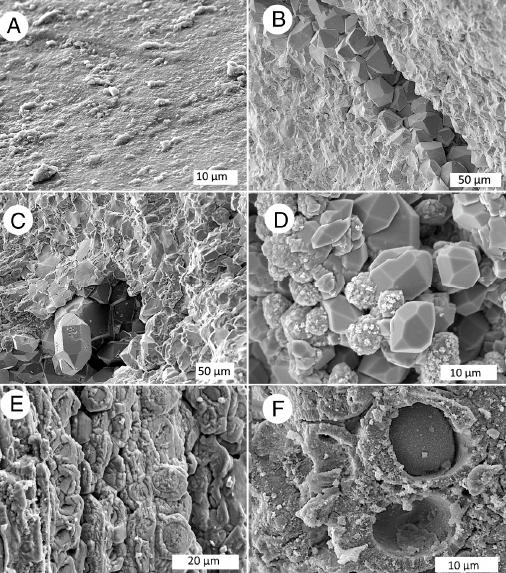
Figure 17. SEM images of Khorat specimens mineralized with quartz/chalcedony. ( A ) Sample S-5, transverse view showing homogeneous quartz. ( B ) A small fracture in sample S-7 is lined with euhedral quartz crystals. The surrounding matrix is microcrystalline. ( C ) Sample S-7 shows a similar structure, where a vessel is lined with euhedral quartz crystals, enclosed by quartz having smaller crystallinity. ( D ) A vessel in sample S-8 has an unusual combination of quartz dipyramids and silica particles having a granular surface texture. This morphology was observed in no other